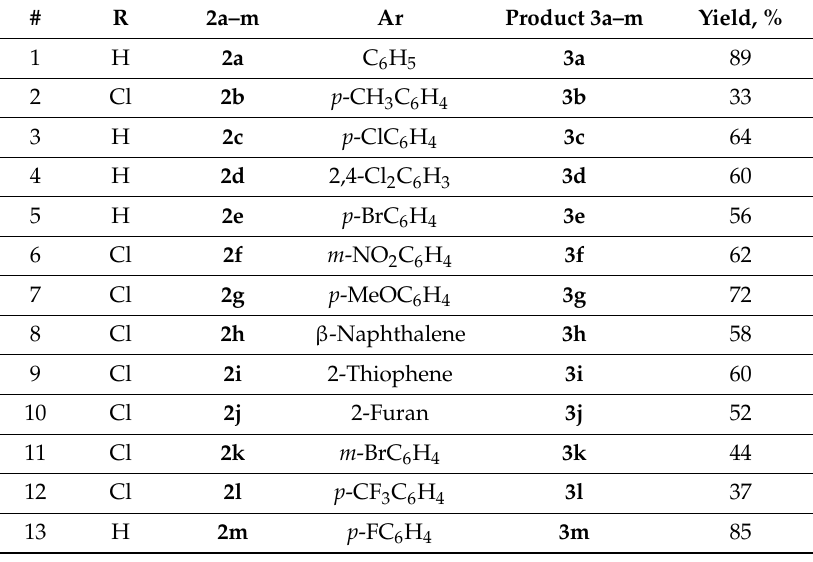
Table 1. Procedure for the synthesis of the target compound 3a – m.